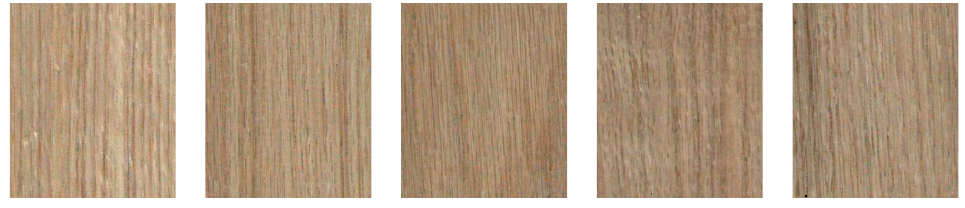
Figure 3. Color difference among wooden boards.